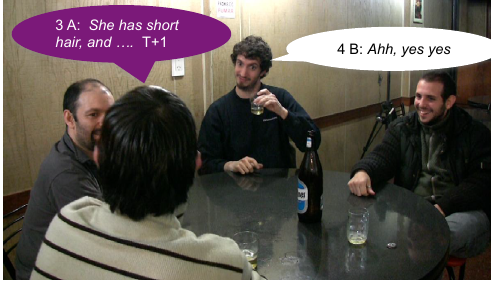
Figure 27 . ‘Sign-name?’ , Person B, middle, initiates repair by repeating a sign-name produced by Person A in line 1.